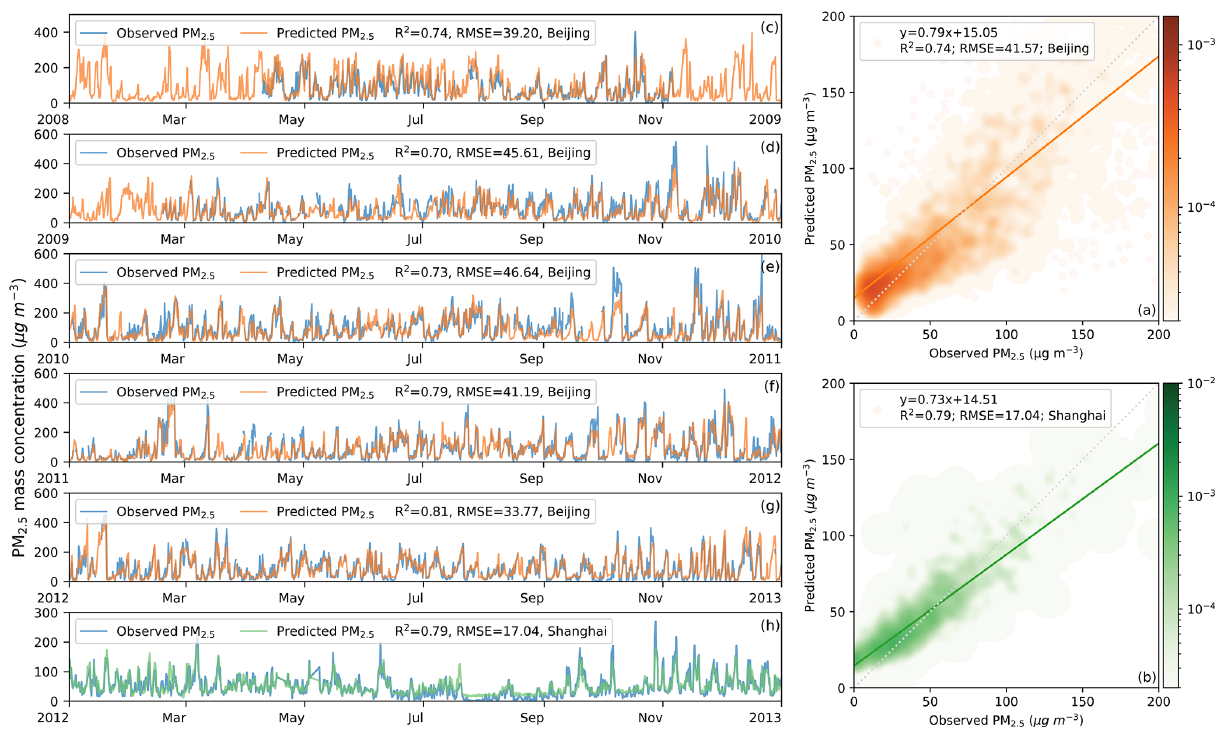
Figure 3. (a) Density scatterplots of observed PM 2 . 5 and estimated PM 2 . 5 between 2008–2012 at the US Embassy in Beijing; (b) density scatterplots of observed PM 2 . 5 and estimated PM 2 . 5 in 2012 at the US Embassy in Shanghai; (c–g) time series of observed PM 2 . 5 and estimated PM 2 . 5 for each year between 2008–2012 at the US Embassy in Beijing; and (h) time series of observed PM 2 . 5 and estimated PM 2 . 5 for each year in 2012 at the US Embassy in Shanghai.